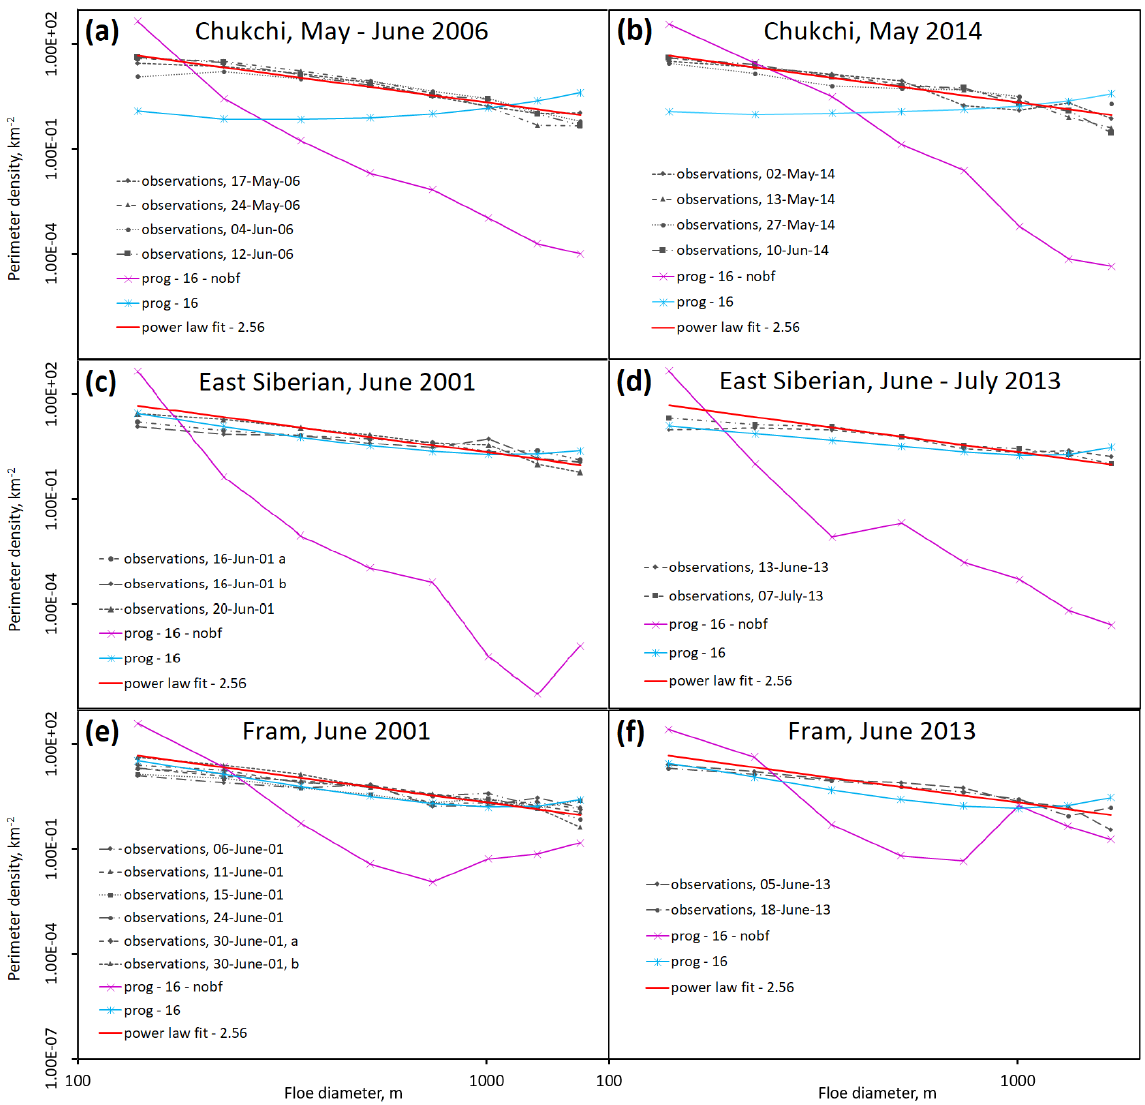
Figure 4. A comparison of the observations and prognostic model output for the perimeter density distributions for the Chukchi Sea in May–June 2006 (a) and May 2014 (b) , the East Siberian Sea in June 2001 (c) and June–July 2013 (d) , and the Fram Strait in June 2001 (e) and June 2013 (f) . Observations are identified with pink or purple dashed lines. Output for prog-16 (light blue, solid, stars) and prog-16-nobf (dark blue, solid, crossed) is averaged across the relevant region identified in Fig. 3 over the stated month(s). The average power-law fit across all locations is also shown (red, solid). The floe size data used within this figure were obtained from imagery using the methodology of Hwang et al. (2017), and the exponent of the power-law fit was calculated according to Virkar and Clauset